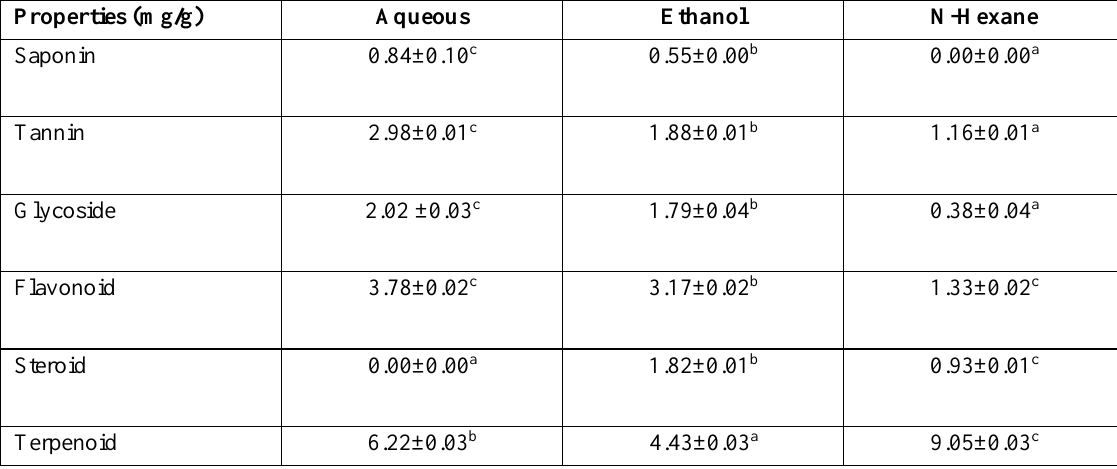
Table 3. Quantitative Phytochemical profile of Leaf Extracts of Citrus aurantium. Properties